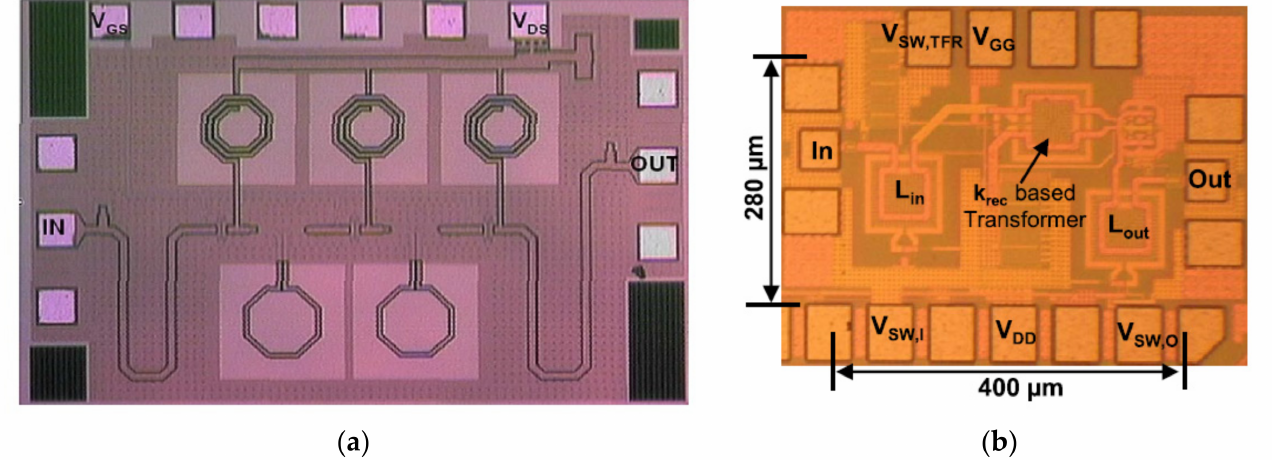
Figure 7. ( a ) Three-stage CS amplifier in 180 nm CMOS [45]. ( b ) One-stage CS amplifier in 60 nm CMOS